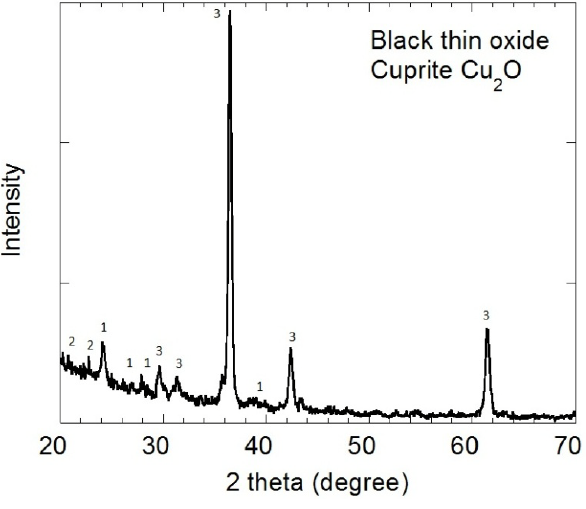
Figure 4. The XRD spectra for the black oxide layer correspond primarily to cuprite (peaks labeled